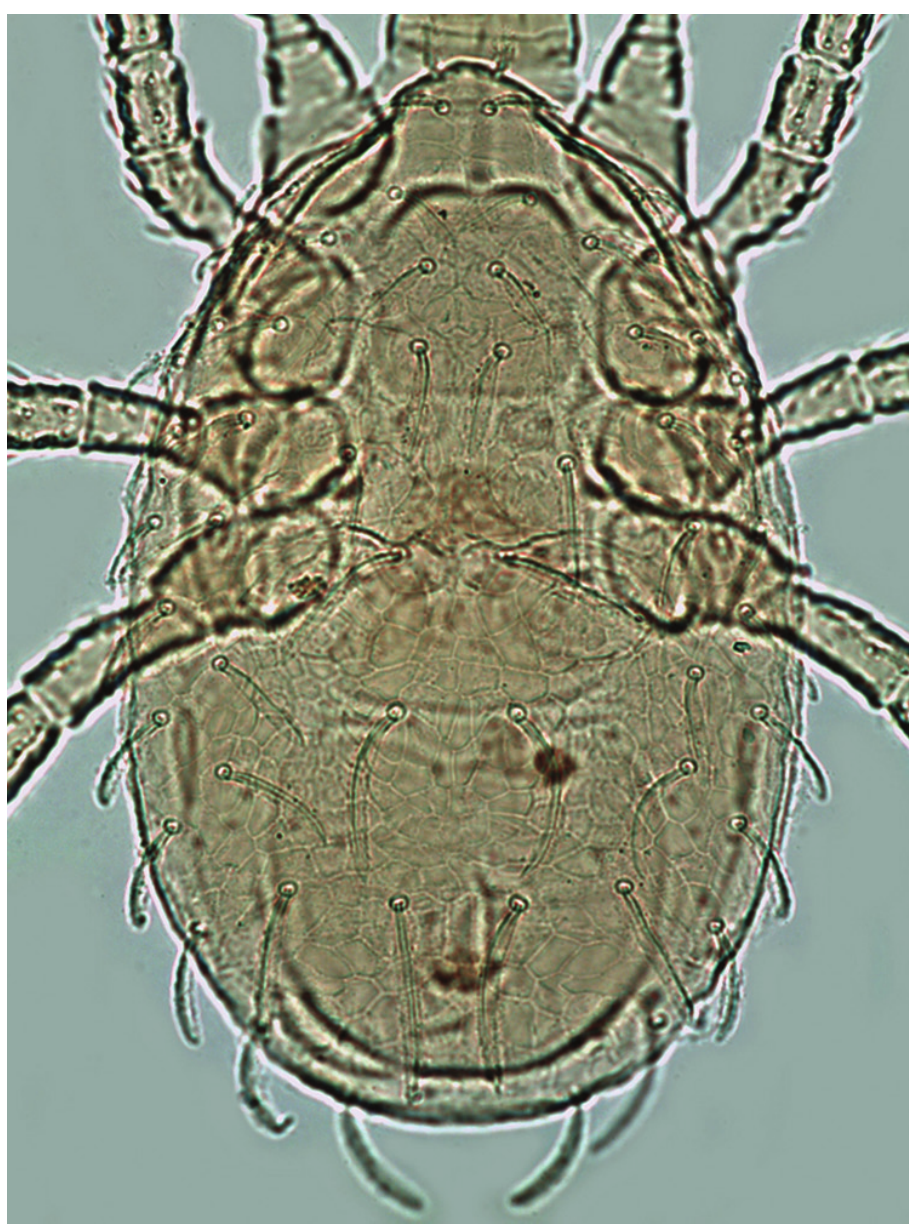
Plate 59. Kleemannia pseudoplumosa , female (from Greece), dorsal idiosoma (pressed